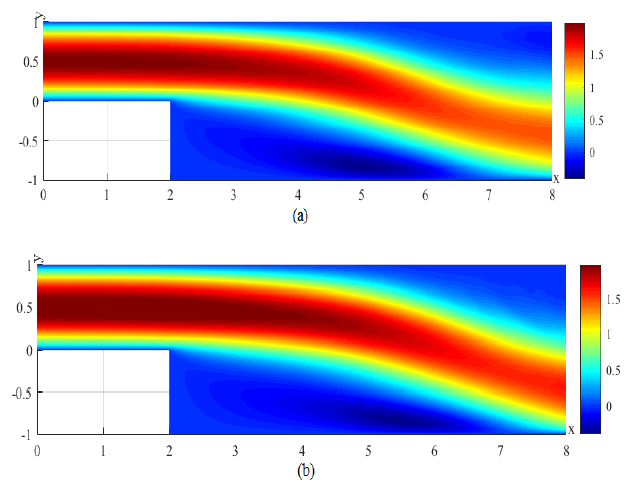
Figure 14. ( a ) The CNMFE solution for u at t = 10. ( b ) The RDRCNMFE solution for u at t =